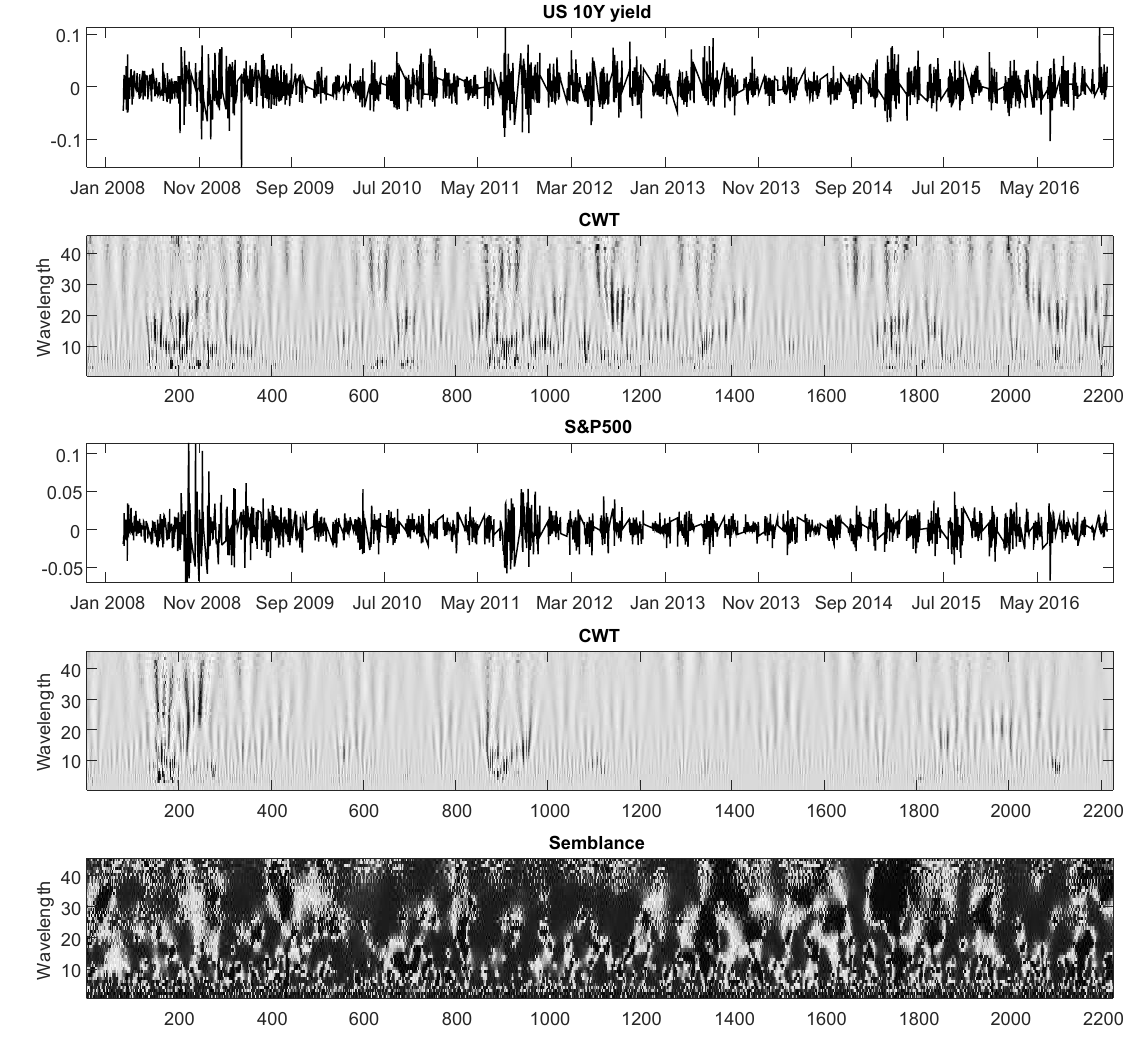
Figure 2. US 10 year treasury yield and S&P500